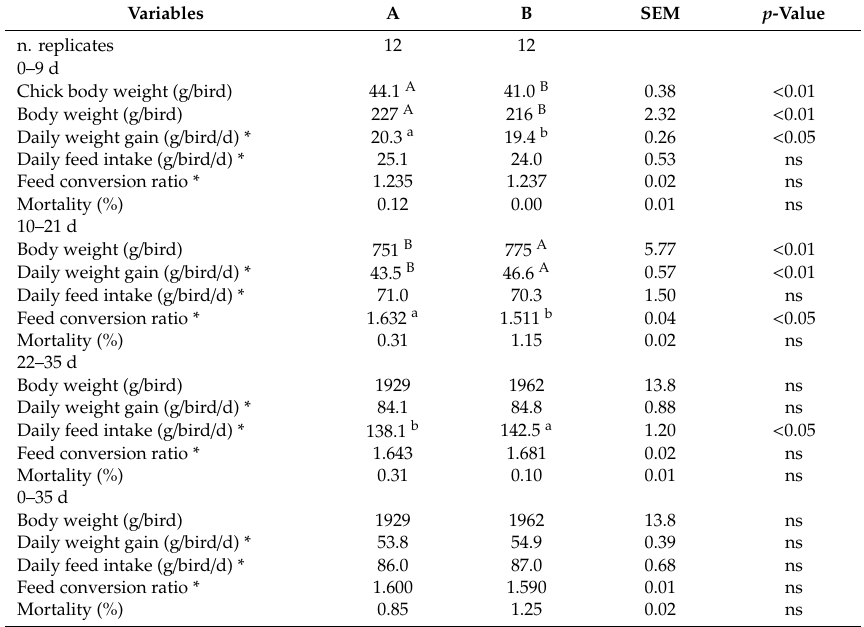
Table 2. Productive performance of broiler chickens of both the genotypes (A and B) in each feeding phase and in the overall period of